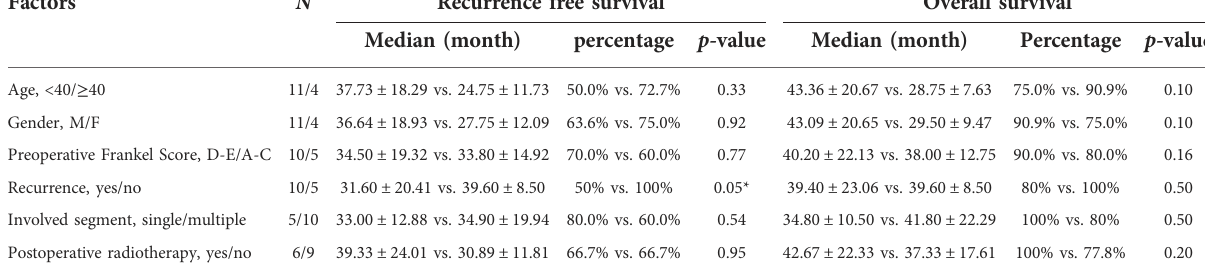
TABLE 3 Univariate analysis of prognostic factors of spinal chondrosarcoma.